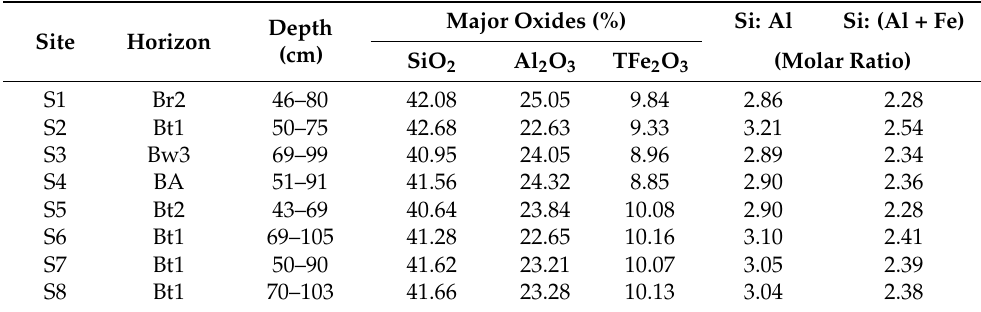
Table 4. Total elements’ content data for soils in the clay derived from carbonate rocks along a climosequence in a subtropical mountain, China.